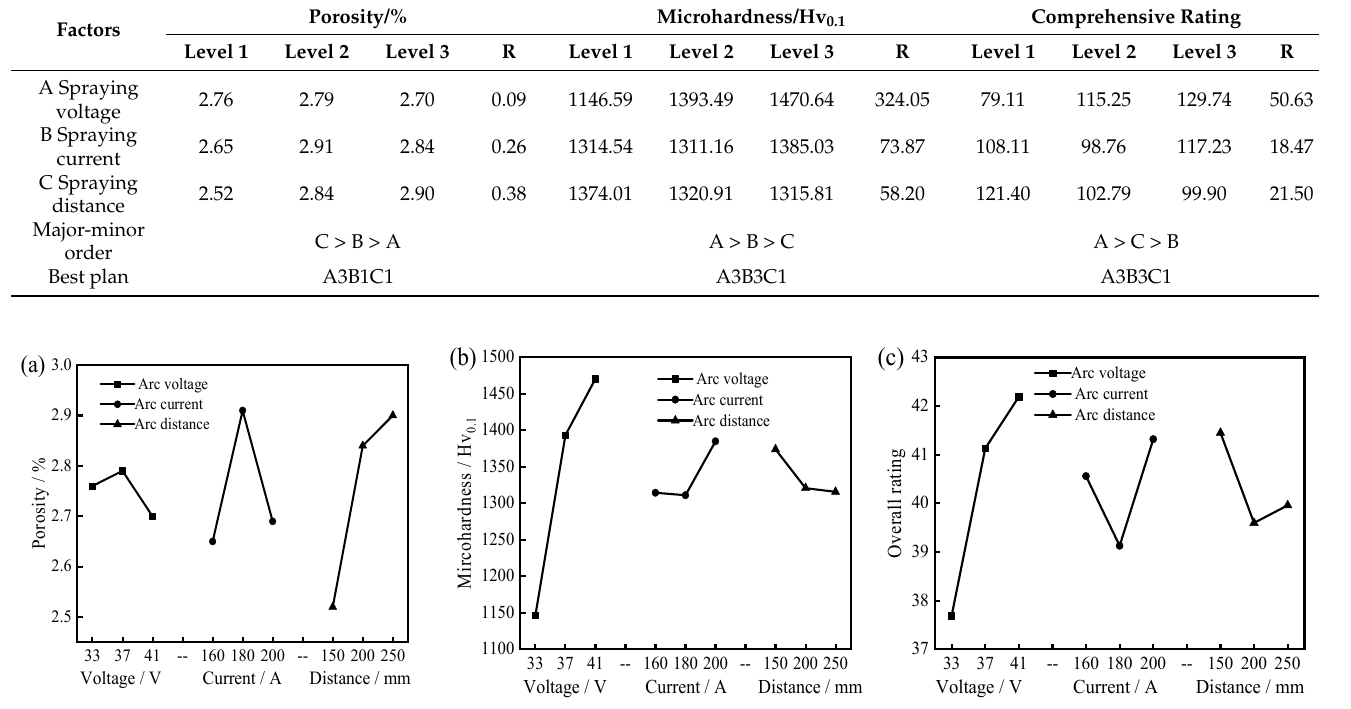
Figure 1. Horizontal trend diagram of orthogonal test with different target parameters ( a ) porosity; ( b ) microhardness; ( c ) comprehensive rating.